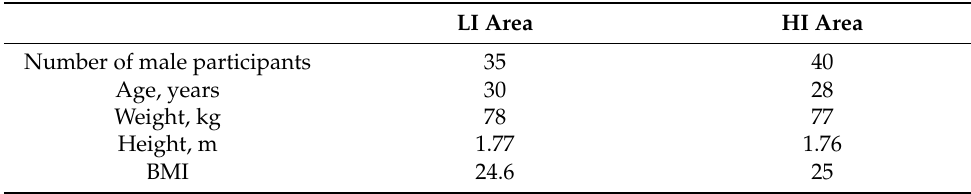
Table 1. Participants’ average